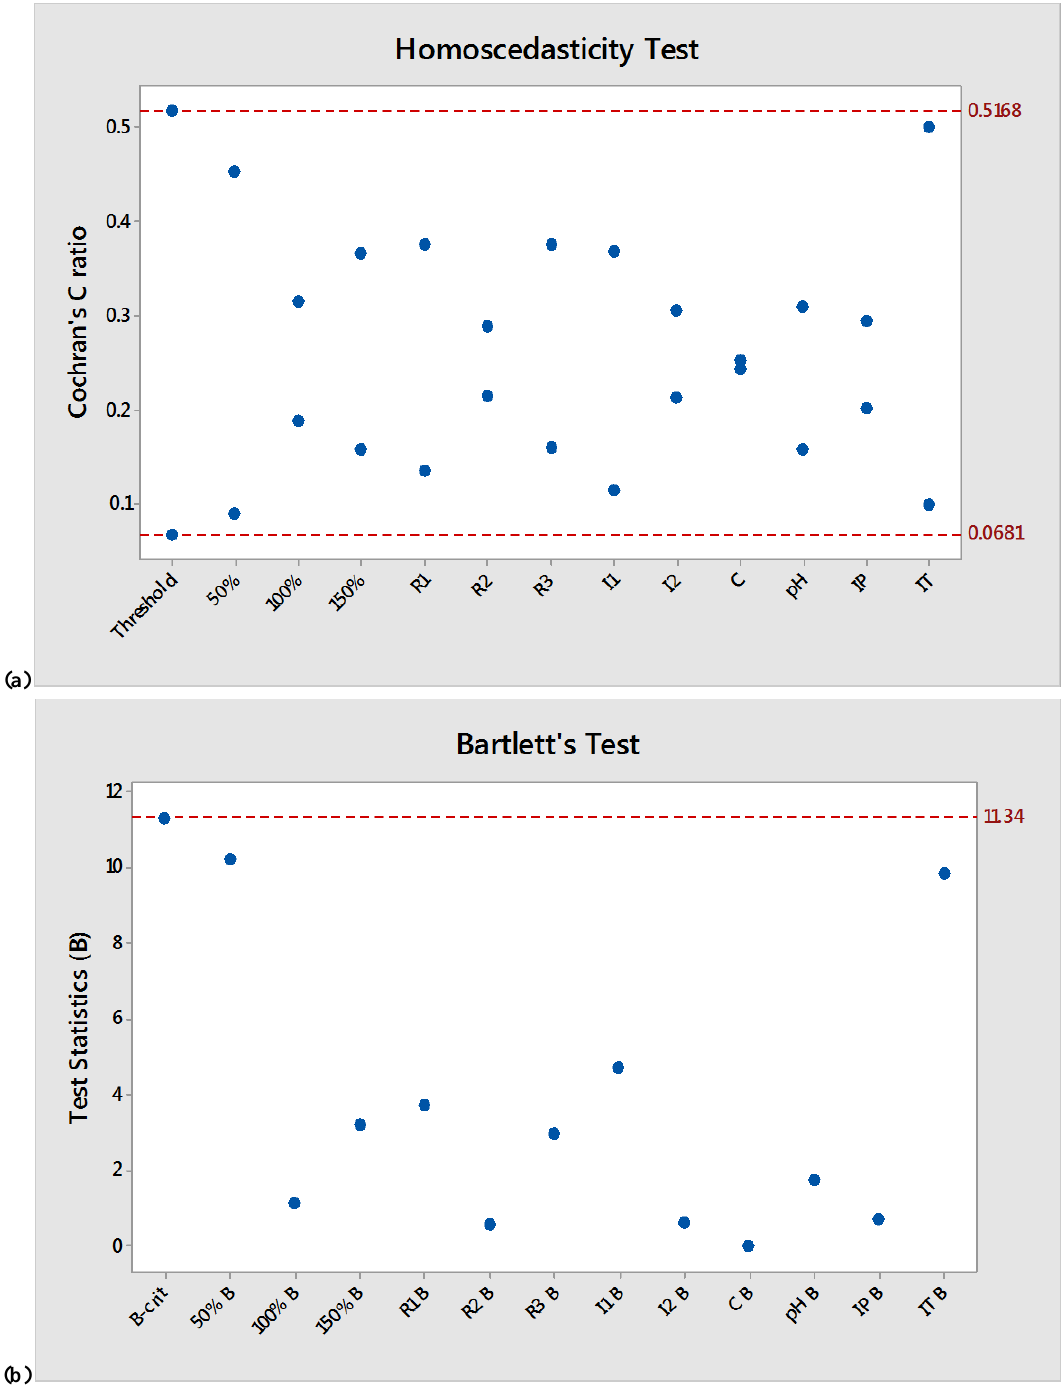
Figure 6. Homogeneity of variance test showing all experimental groups (R: Repeatability, I: intermediate precision, IP: Incubation Period, IT: Incubation Temperature, 50%: 50% accuracy test, 100%: 100% accuracy test and 150%: 150% accuracy test) within critical values (red dashed line) using: (a) Cochran's test (b) Bartlett's